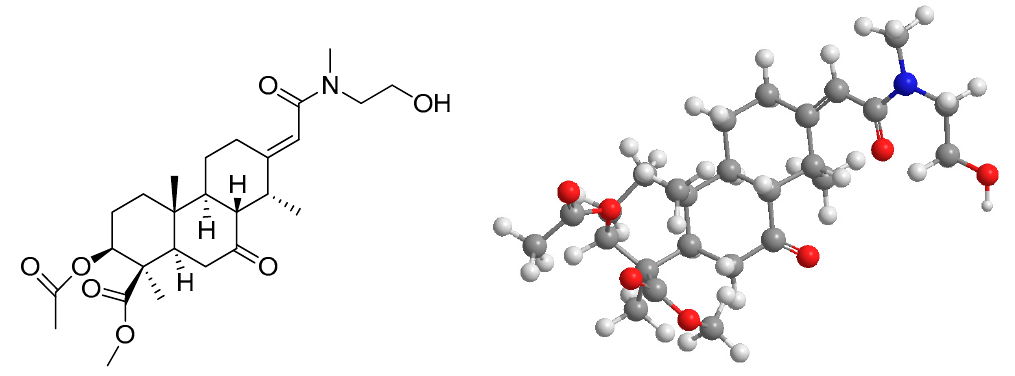
Figure 1. 1D and 2D chemical structure of 3AEP.